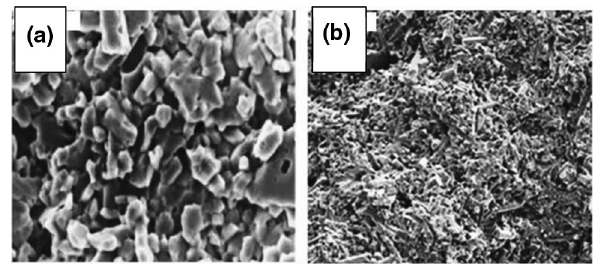
Fig. 10 SEM picture of a catfish bone b bovine bone hydroxyapa- tite obtained at 900 °C [45]